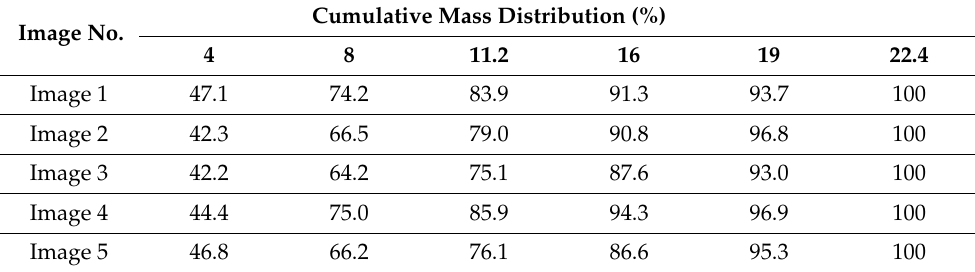
Table 4. The cumulative rock mass distribution of images 1 to 5.